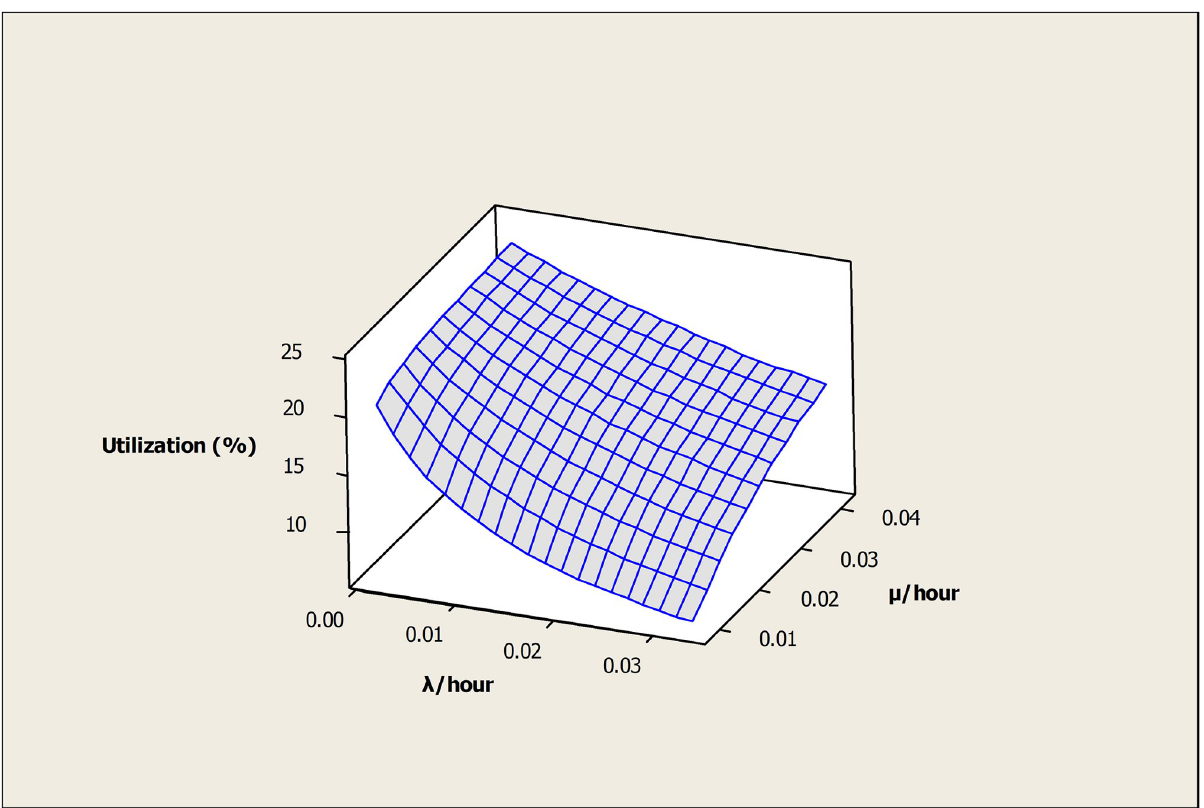
Fig 17. Surface plot of production rate/hour versus μ /hour, λ